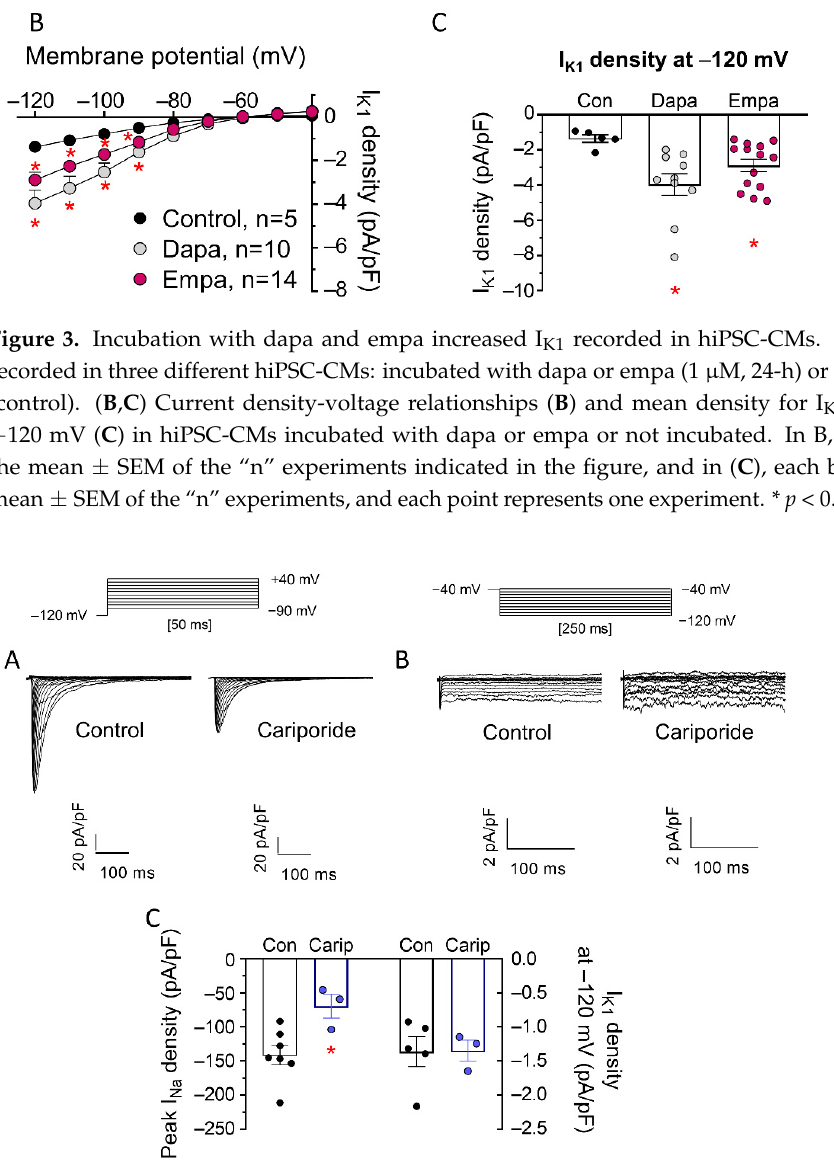
6.5±0.5 15.0±2.4 − 91.4±2.2*# 5.5±0.3